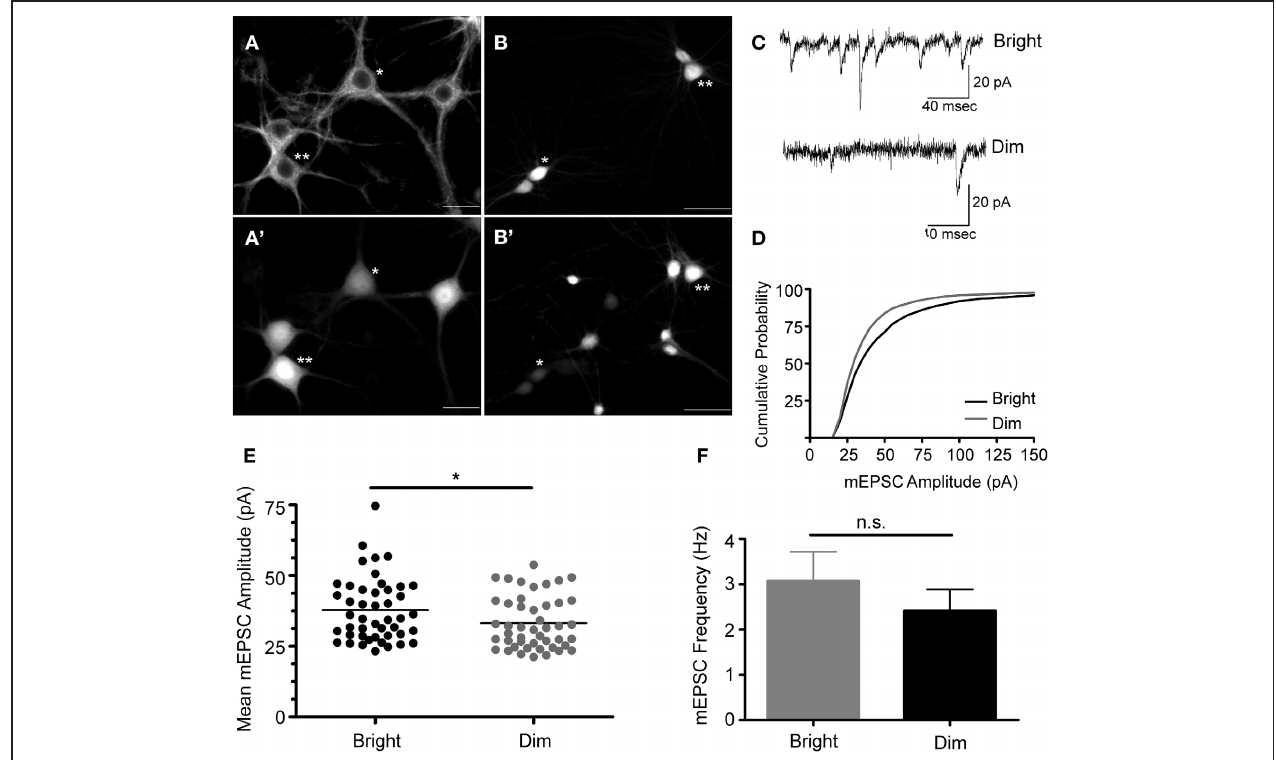
neurons. (D) Cumulative probability distribution for the amplitude of recorded mEPSCs in cells strongly expressing (bright) or weakly expressing (dim) GFP. (E) Vertical scatter plot showing the mean mEPSC size for a 5min recording session for bright ( n = 46) and dim cells ( n = 46). (F) Average mEPSC frequency for the recordings shown in panel E . Between group statistical significance was determined using the Mann–Whitney test, ∗ p < 0 .